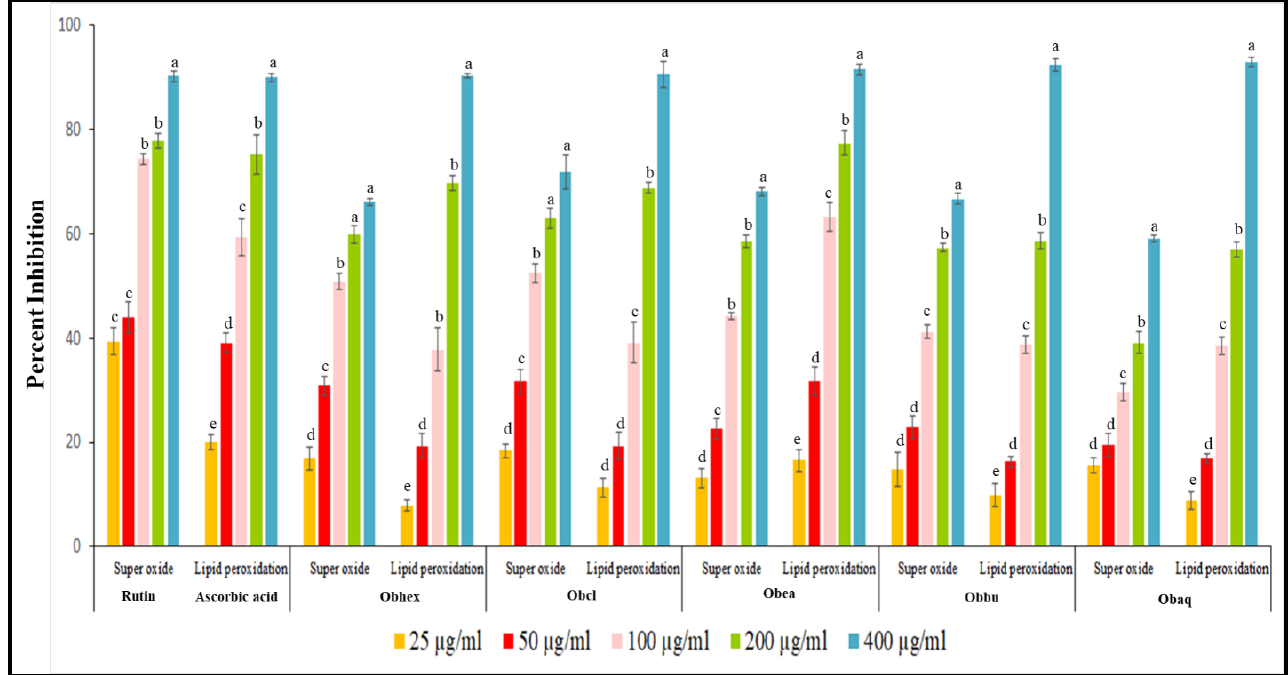
Figure 1. Antioxidant potential of various fractions obtained from O. bracteata using superoxide anion radical scavenging assay and lipid peroxidation assay. Results showed Mean ± SE of performed three experiments independent in triplicates. Data labels with different letters represent significant difference among them at ( p ≤ 0.05).